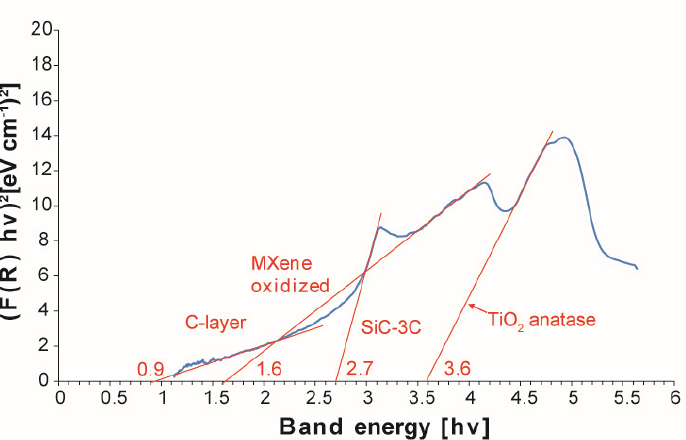
Figure 6. The plot of the Kubelka-Munk function in a function of band energy for SiC–C–B– Ti 3 C 2 MXene annealed at 1600 °C in vacuum,.